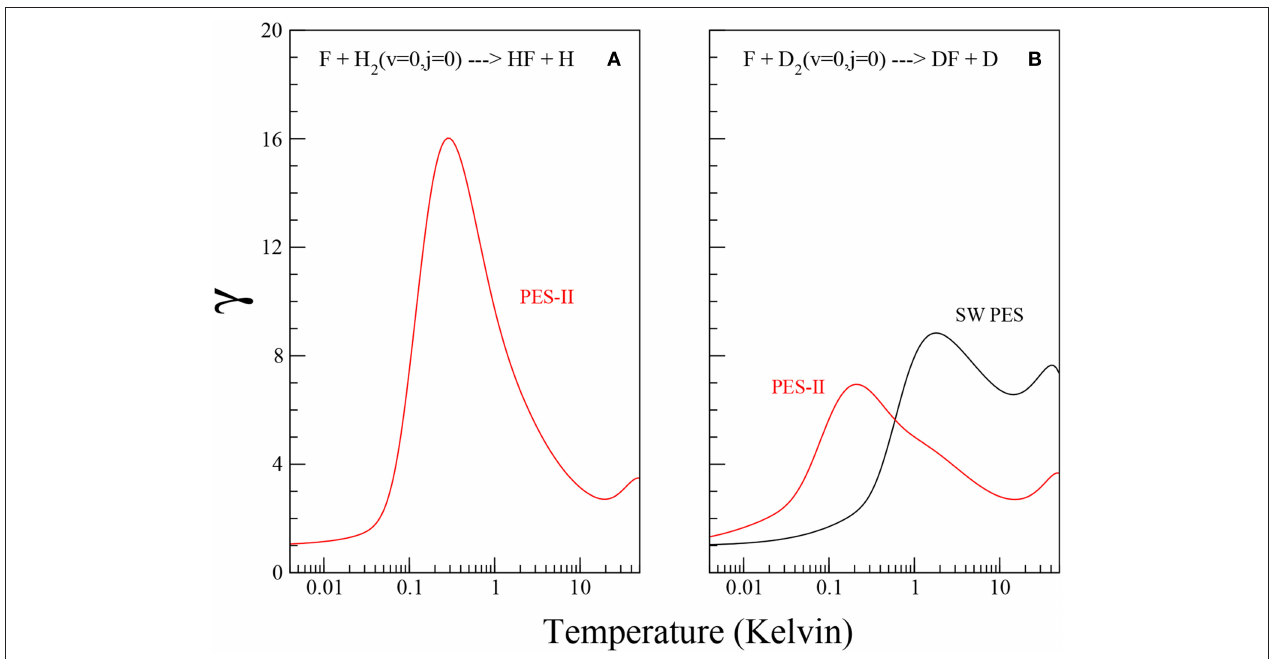
FIGURE 3 | Plots of the γ coefficient as defined in Equation (13) for the F+H 2 and F+D 2 reactions, panels (A,B) , respectively, on the SW PES (black solid lines) and PES-II (red solid lines).